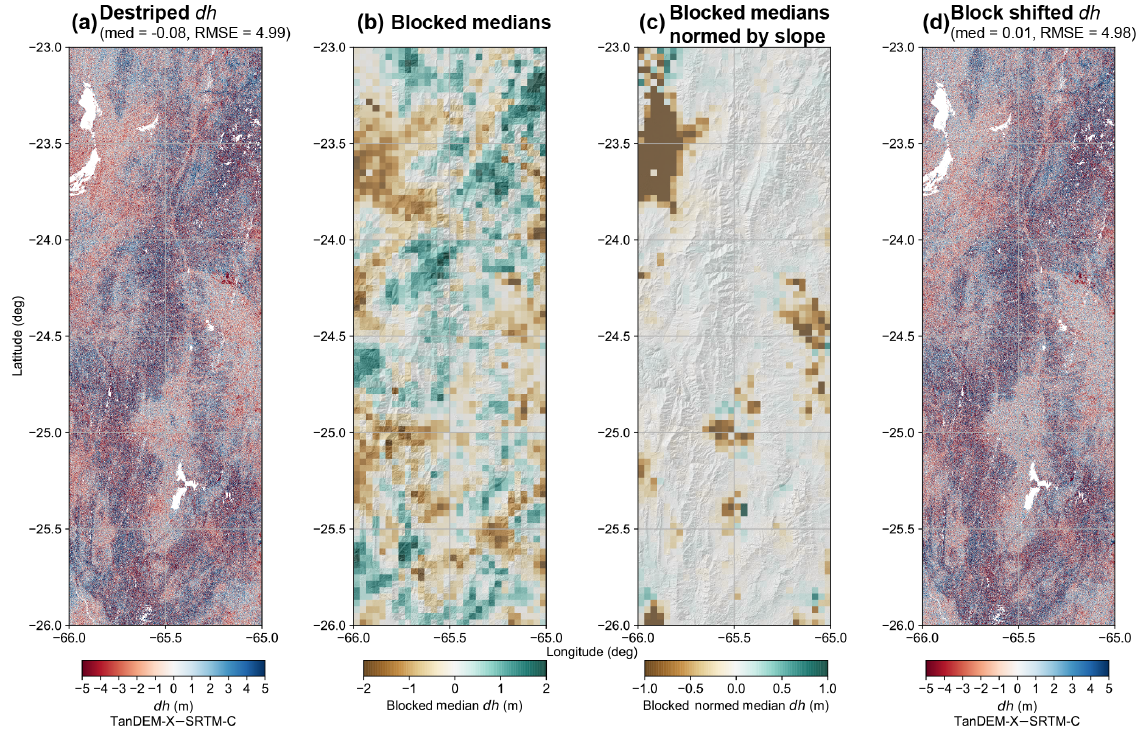
Figure 4. Blocked shifting on three destriped and merged tiles (24–26 ◦ S, 66 ◦ W). Blocks are 3.6km in height and width. The (a) destriped median and RMSE both improve slightly in (d) the final shifted dh map. Note that the original blocked medians (b) show a slight pattern resembling the long-wavelength stripe bias from SRTM-C. In (c) we have normalized the median shifts by the median slope values, so as not to overcorrect the steeper regions with higher uncertainties. The color scheme is changed for (b) and (c) , and the scale of (c) is half the width of (b) since it only extends to the maximum allowable shift of ± 1m. Scales and color scheme in (a) and (d) are identical. Voids (white space) are untrustworthy pixels removed by TanDEM-X WAM cutoff prior to median